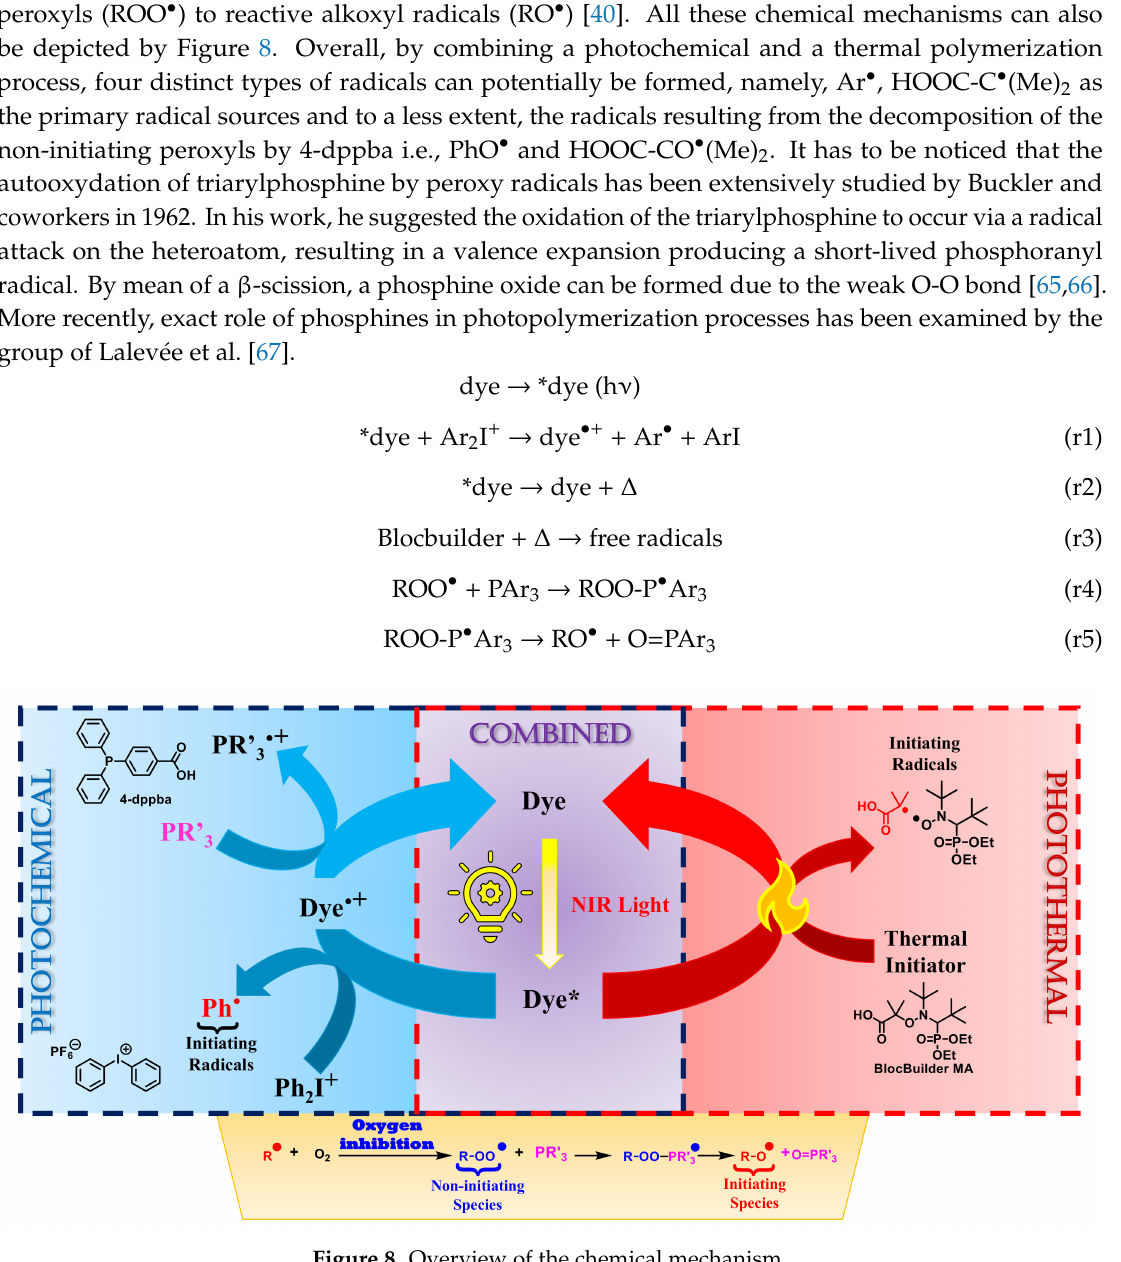
Figure 8. Overview of the chemical